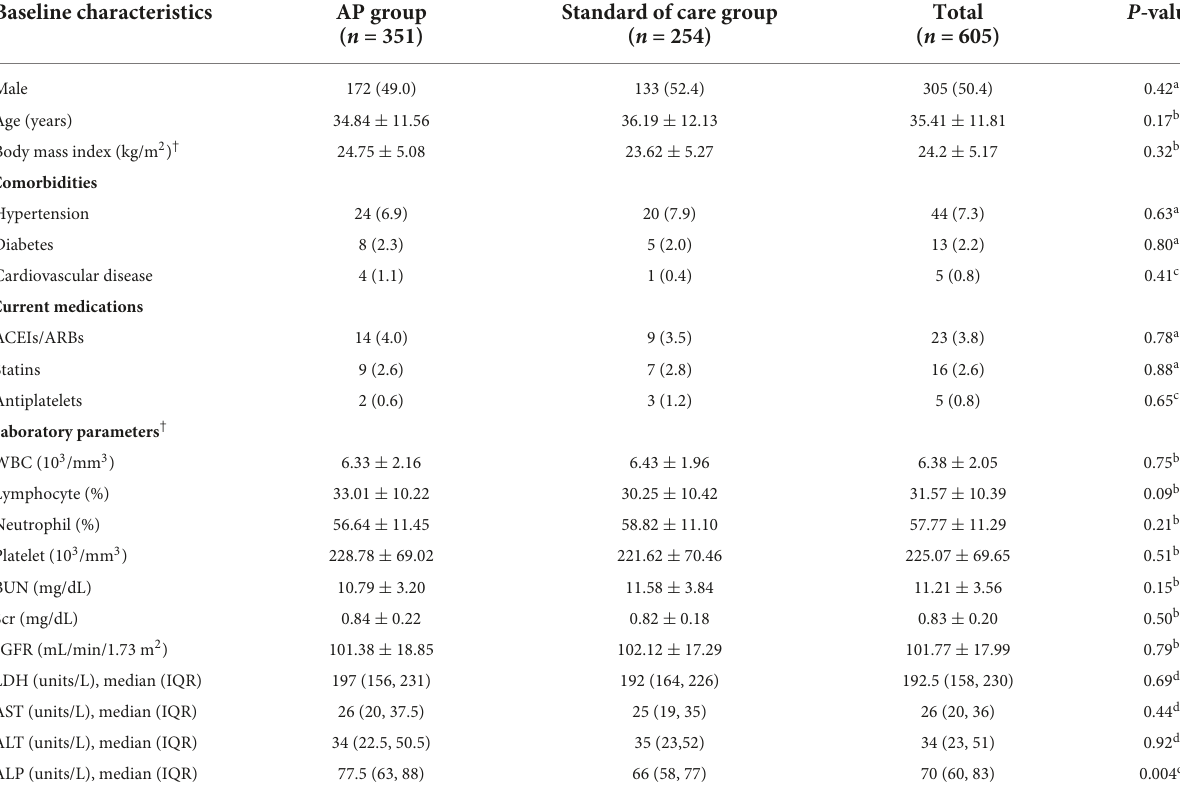
TABLE 1 Baseline characteristics of the study populations. Baseline characteristics